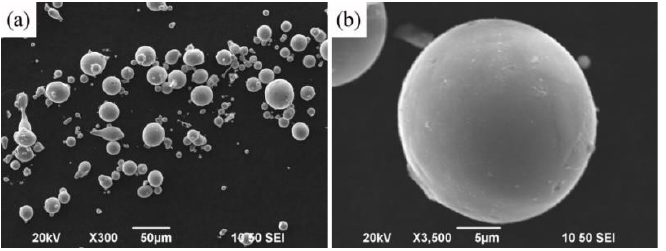
Figure 1. SEM morphology of the Fe-Cr-B-C powder. ( a ) is general situation of coarse and fine particles, and ( b ) is surface state of a spherical powder.